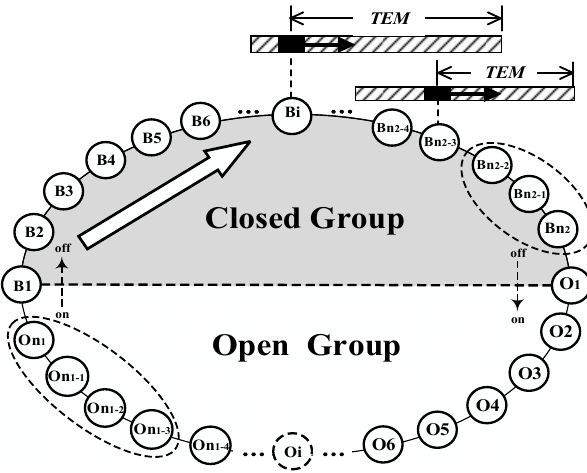
Figure 8. Schematic diagram of NTEM -based priority list.